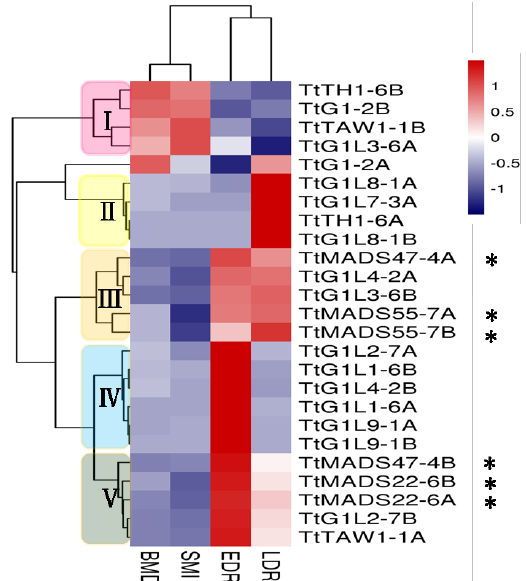
Figure 3. Heat map showing the expression profiling of the TtALOG , TtMADS22 , TtMADS47 , and TtMADS55 genes at the early stages of inflorescence development in GAN-A631 (bh). The relative expression levels are shown in the heat map by a gradient of color: blue/white/red (low to high). Abbreviations: EDR, the early double ridge stage; LDR, the late double ridge stage; BMD, the branch meristem development stage; SMI, the spikelet meristem-initiated stage. The heat map color key gradient ranging from global minimum (blue) − 1 to global maximum (red) +1 is shown on the right side. Asterisks indicate the TtMADS22 , TtMADS47 , and TtMADS55 of GAN-A631. To further verify the functions of groups III–V in BM development, the expression patterns of their genes, TtTAW1-1A , TtG1L4-2A , TtG1L4-2B , TtG1L1-6B , and TtG1L2-7A , were investigated by qRT-PCR analysis in GAN-A631 and GAN-A1582 (Figure 4). The results showed that the expression of these genes was downregulated during the EDR, LDR, BM development, and SMI stages in GAN-A631 as well as during the EDR, LDR, GP, and LP stages in GAN-A1582. (Figure 4). In contrast to normal head wheat, the expression levels of TtTAW1-1A , TtG1L4-2B , and TtG1L1-6B were much higher in branching head wheat, especially for TtTAW1-1A (homologous gene of TAW1 ). The mRNA